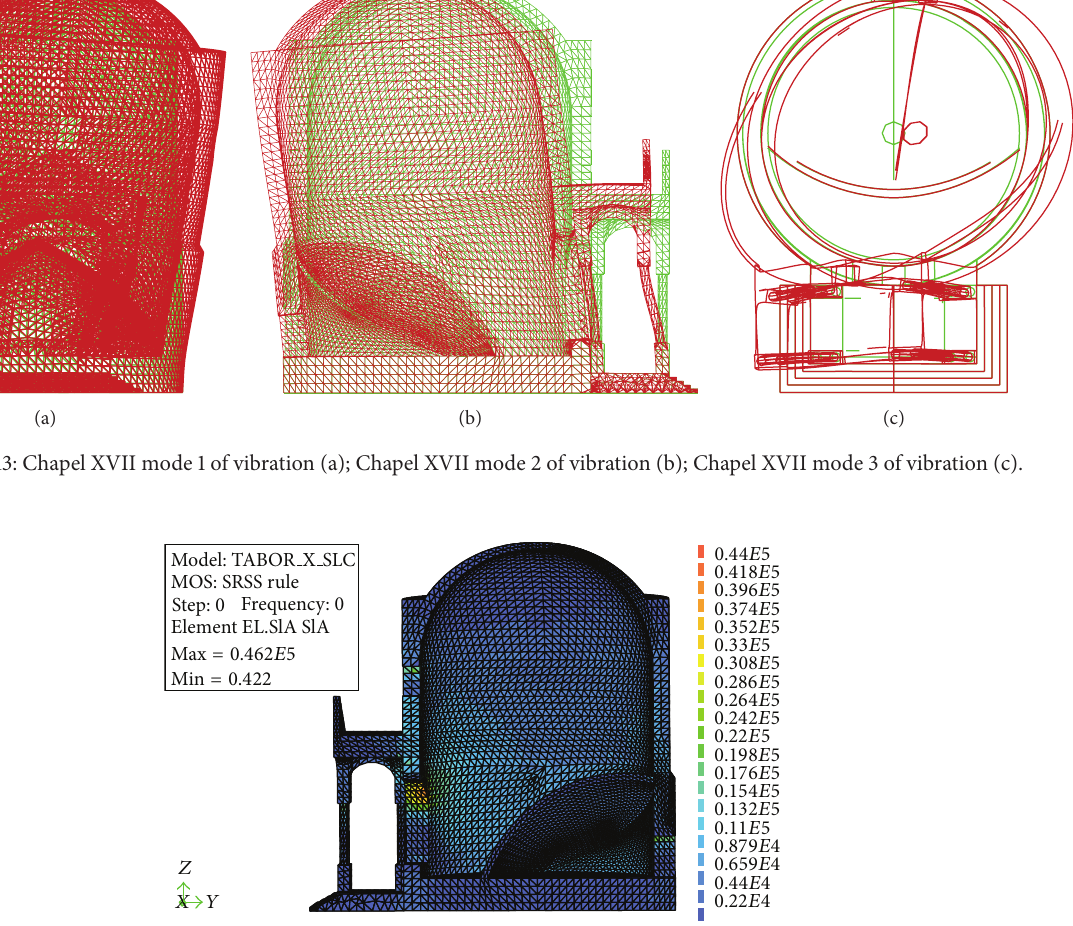
Figure 14: Chapel XVII principal SRSS stress contour, measured in Pa, during simulated earthquake in the X